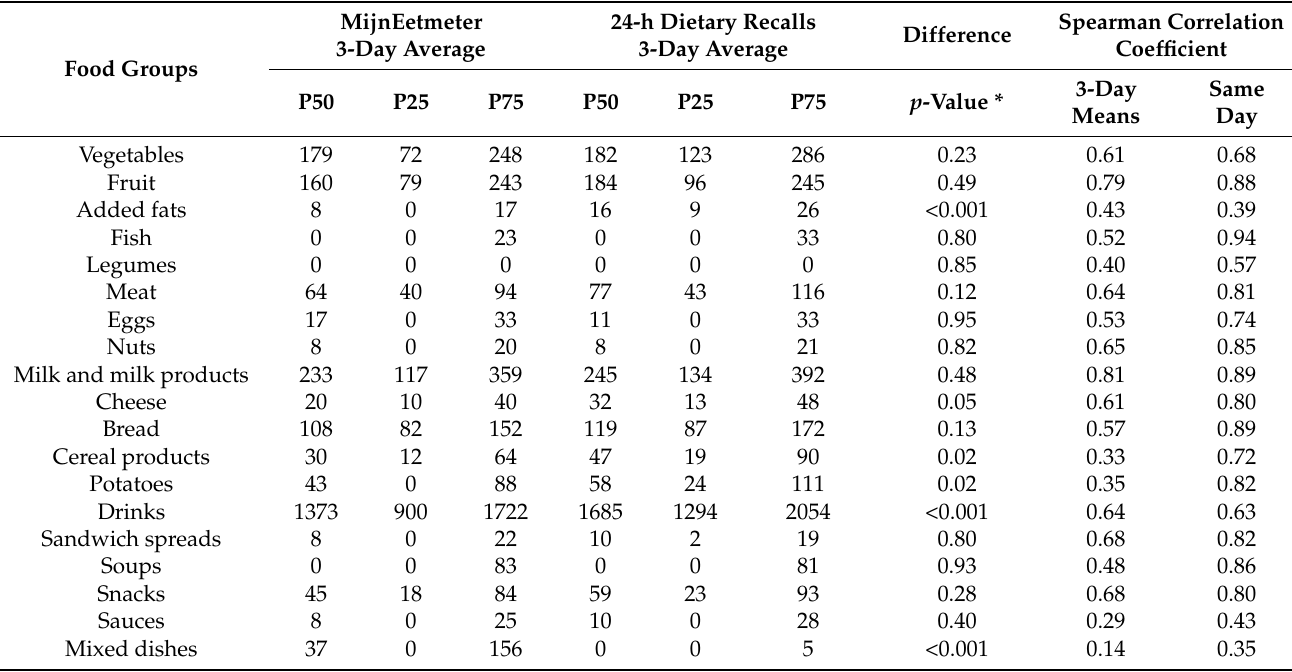
Table 2. The 50th, 25th, and 75th percentile of consumption of food groups (g/day) as assessed with MijnEetmeter and with 24-h dietary recalls and their correlation in MijnEetmeter Study ( n =